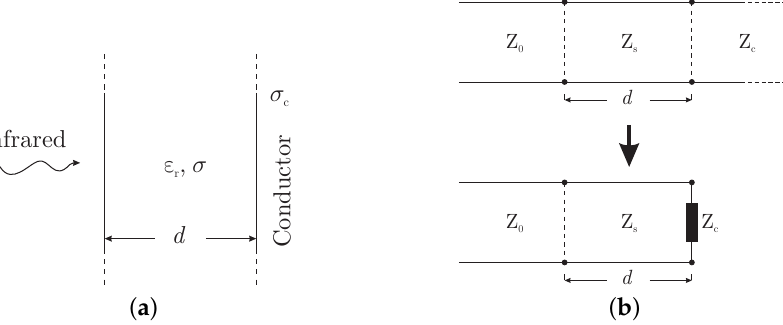
Figure 2. ( a ) The configuration under study, consisting of a thin dielectric slab along with the terminating conductor, and ( b ) the featured equivalent transmission line model, for the estimation of the unknown